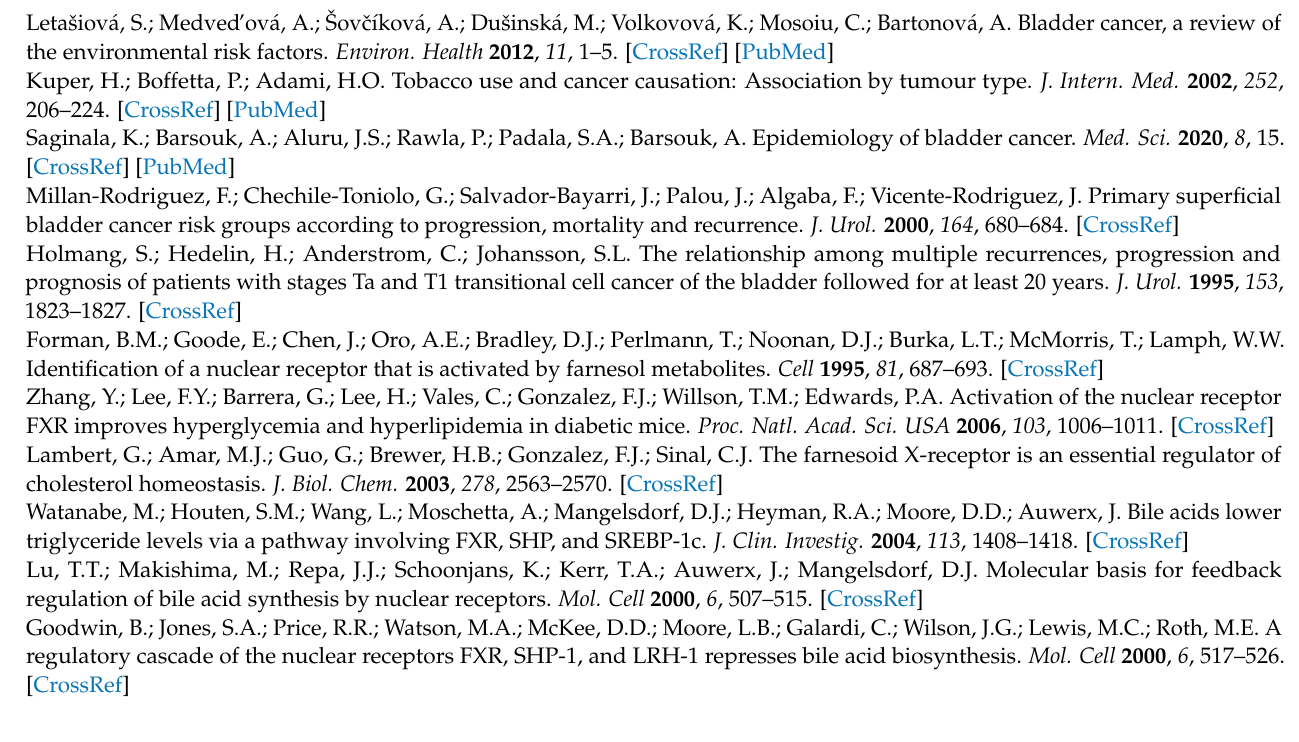
expression on overall survival in human bladder cancer patients and protein expression in bladder cancer cell lines. Figure S3: The effect of FXR overexpression combined with atorvastatin treatment on adhesion. Figure S4: The effect of cholesterol application on migration and invasion. Figure S5: Cholesterol application reversed the FXR overexpression-mediated inhibition of tube formation. Figure S6: Original blots. Table S1: The information of